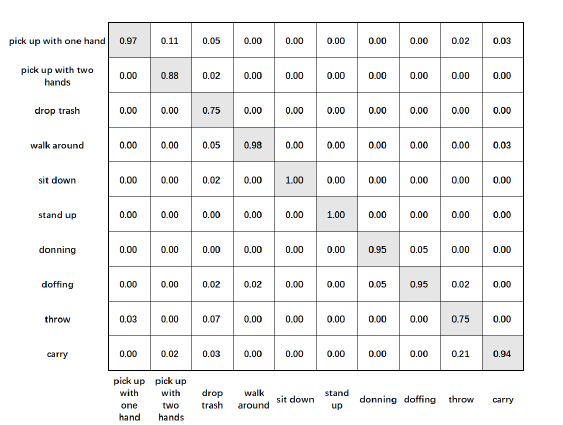
Figure 5. Comparison Confusion matrices of the MTANs on the Northwestern-UCLA dataset. The row of the confusion matrix denotes the true action label, while the column denotes the predicted action classes. The value in each column is the probability that the real data is predicted to be that